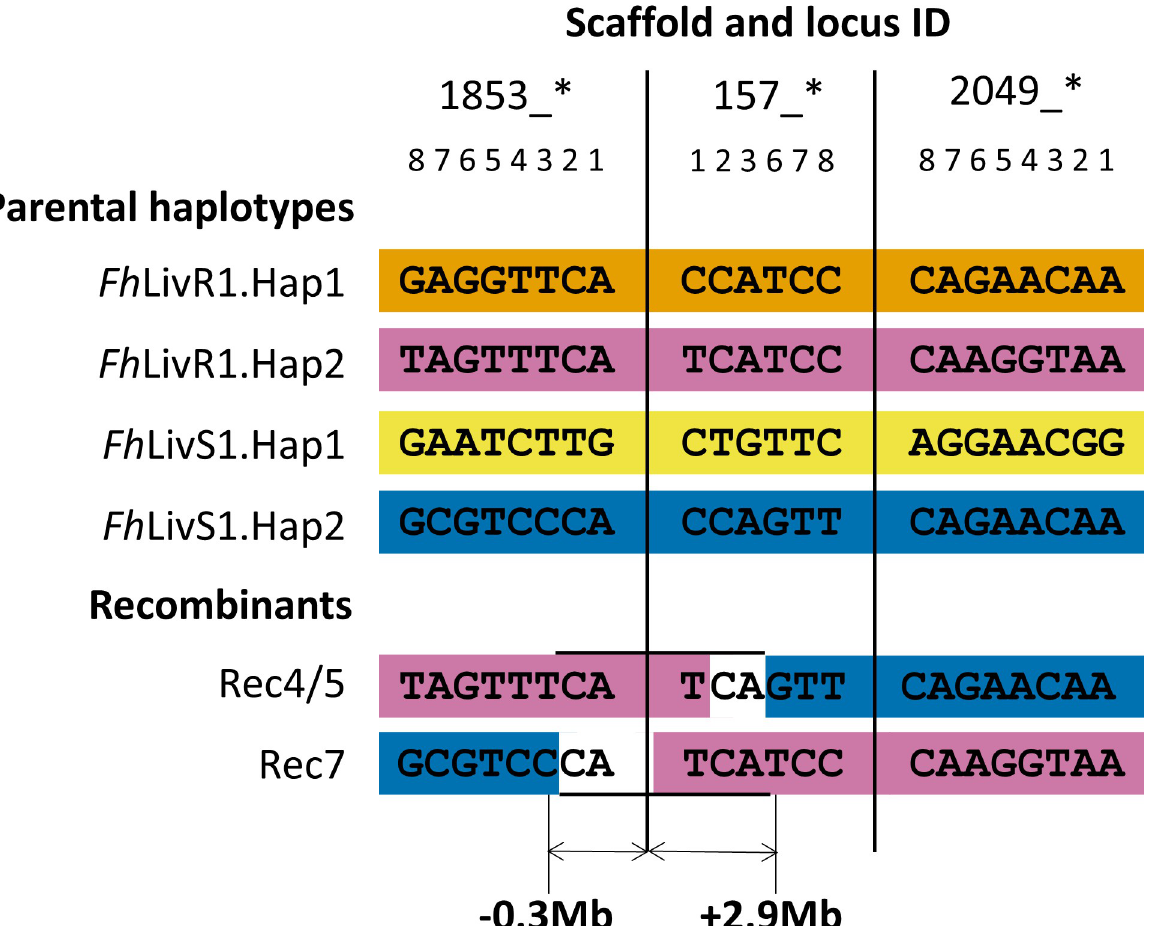
Fig 4. Schematic to demonstrate finer scale mapping of the genomic region under selection in recombinant F2s compared to parental haplotypes. Parasites (treated and untreated) were individually genotyped at 36 loci across the six scaffolds under selection. PHASE 2.1.1 [30,31] was used to infer haplotypes from the SNP data and the parental haplotypes ( Fh LivR1.Hap1; Fh LivR1.Hap2; Fh LivS1.Hap1; Fh LivS2.Hap2) were identified. The figure shows the individual genotypes for the loci on scaffolds 1853, 157 and 2049 (note that even though the sequences are consecutive in the diagram the individual loci are not physically next to each other; the nucleotide position of these loci across each scaffold can be found in S4 Table). Analysis of informative resistant recombinant haplotypes (Rec4/5 and Rec7; S5 Table) found within surviving F2 parasites (i.e. those from treated animals) allowed us to further localise the area needed for a parasite to be resistant. In these recombinants, recombination between SNPs delineates a single genomic locus from 1853_3 to 157_6 (~3.2Mbp; 0.3Mbp region of scaffold 1853 and a 2.9Mbp region of scaffold 157) that was consistently inherited in surviving F2 parasites (S5